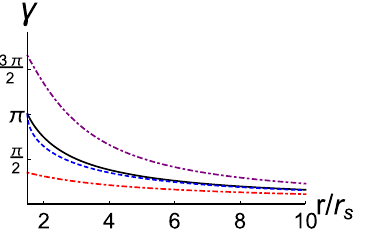
Fig. 4 The angle γ as a function of the radial distance r / M for the static observer. The magnetic charge Q m is set to Q m = 0 . 1 ¯ M (the black solid line), Q m = 0 . 5 ¯ M (the blue dashed line), and Q m = 0 . 8 ¯ M √ 3 κ 4 (the red dot dashed line), and ¯ M is defined as 8 π